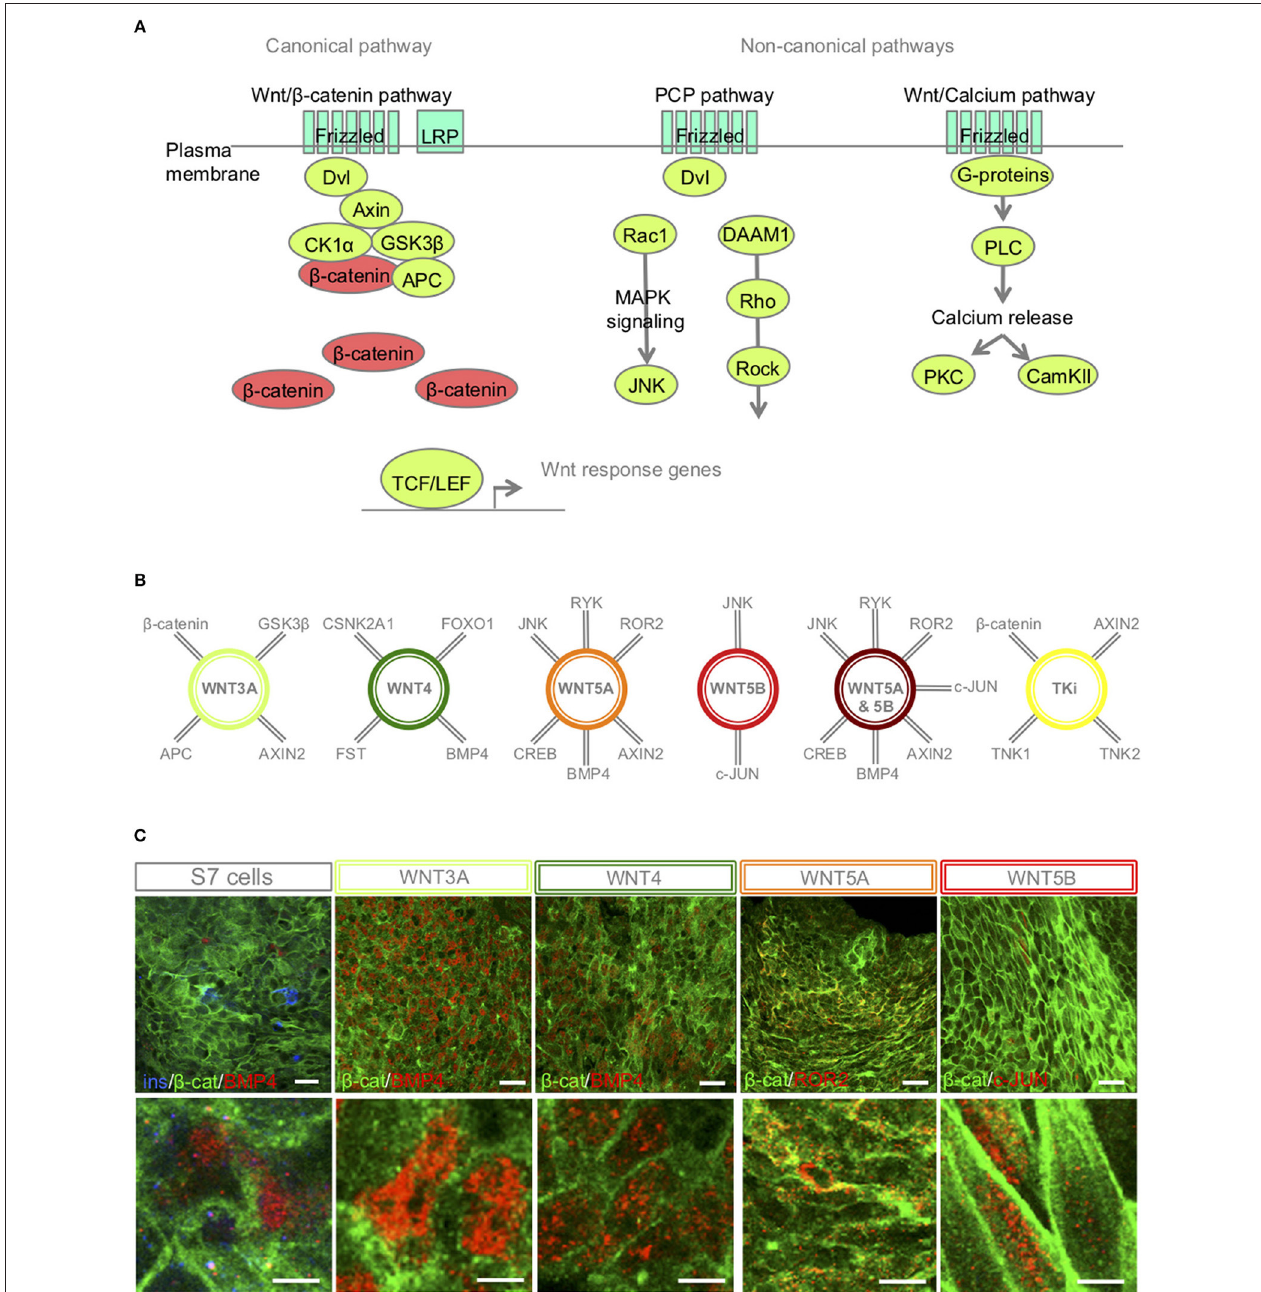
FIGURE 2 | S7-cells show heterogeneous expression of downstream targets 48h after Wnt-modulator treatment. (A) Schematic overview of key proteins of the canonical and non-canonical Wnt signaling pathways, in brief, Wnt ligand binds to its receptor Frizzled and co-receptors LRP5/6, receptor tyrosine kinase, (or ROR2) and transmits the signal via disheveled (Dvl) into the cytoplasm to activate the canonical Wnt pathway, or functions through non-canonical planar cell polarity (PCP) and Wnt/Ca 2 + . In the canonical Wnt signaling pathway, β -catenin accumulates in the cytoplasm and translocate to the nucleus to act as a transcription coactivator for the TCF/LEF transcription factor family. Without Wnt, β -catenin is degraded by the destruction complex, composed of Axin, adenomatosis polyposis coli (APC), glycogen synthase kinase 3 β (GSK3 β ) and casein kinase 1 α (CK1 α ). The non-canonical Wnt/PCP pathway is thought to use Ryk or ROR2 for activation; Dvl is recruited to form a complex with disheveled-associated activator of morphogenesis 1 (DAAM1). DAAM1 activates Rho that again activates Rho-associated kinase (ROCK). Dvl can also form a complex with Rac1 to activate JNK via the MAPK pathway. In the Wnt/Ca 2 + pathway, binding of Wnt to Frizzled activates a trimetic G-protein leading to activation of PLC to cleave PIP2 to form DAG and IP3. IP3 binds to its receptor on the endoplasmic reticulum and calcium is released. Increased concentrations of calcium and DAG can again activate PKC and CaMKII. (B) A selection of interaction partners of the selected Wnt-ligands (30–33). (C) IF of β -catenin, BMP4, ROR2 and c-JUN in S7 cells, WNT3A, WNT4, WNT5A, WNT5B treated S7 cells, respectively. Scale bar 50 µ m.